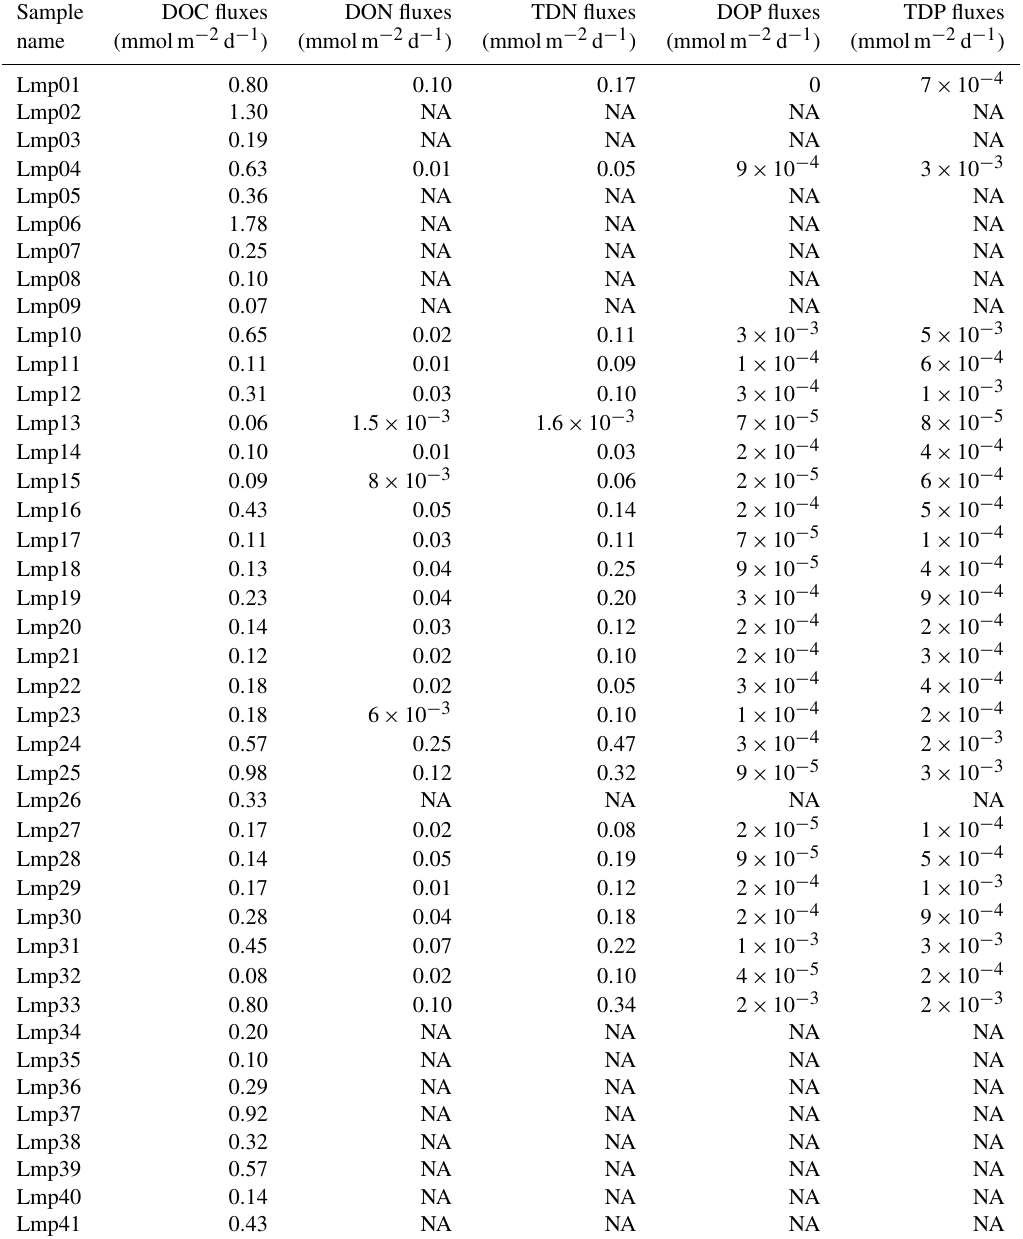
Table 2. Atmospheric fluxes of DOC, DON, TDN, DOP, and TDP on the island of Lampedusa.